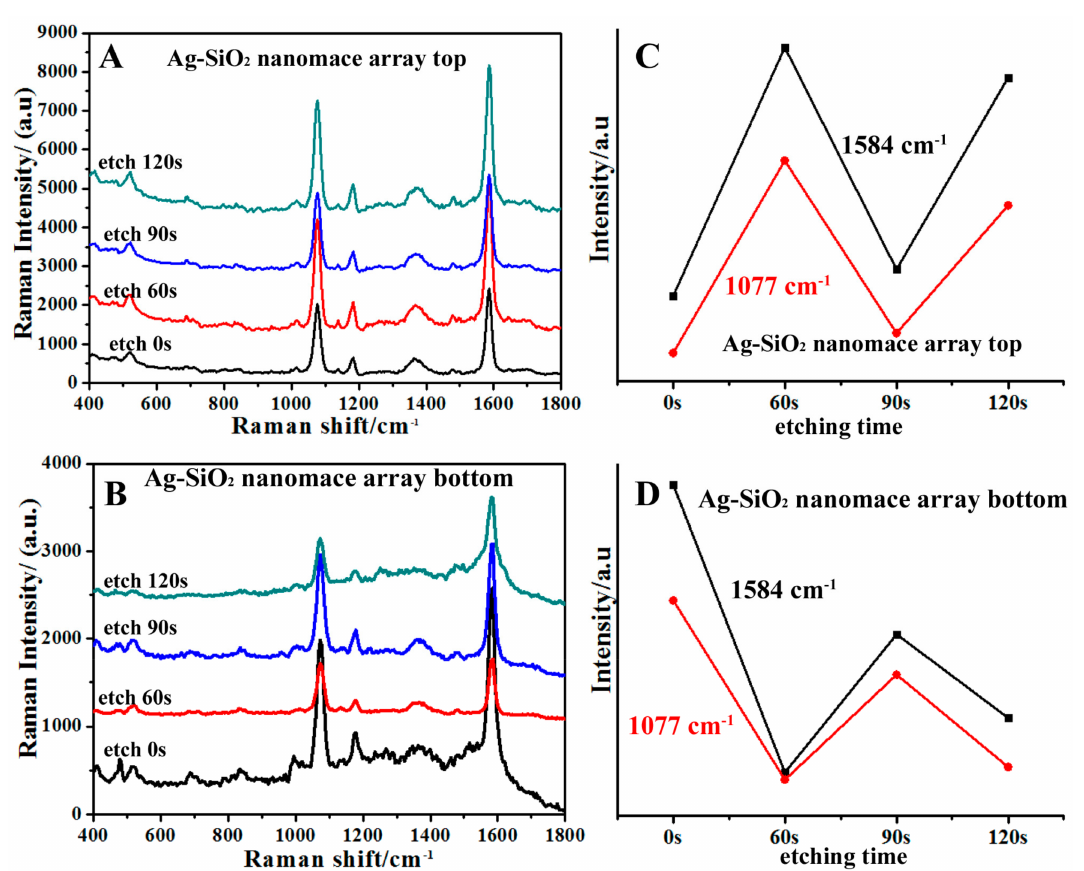
Figure 4. Raman spectra of top ( A ) and bottom ( B ) of nanomace array substrates; ( C ) and ( D ) show the corresponding dependence of the Raman signal intensity on etching